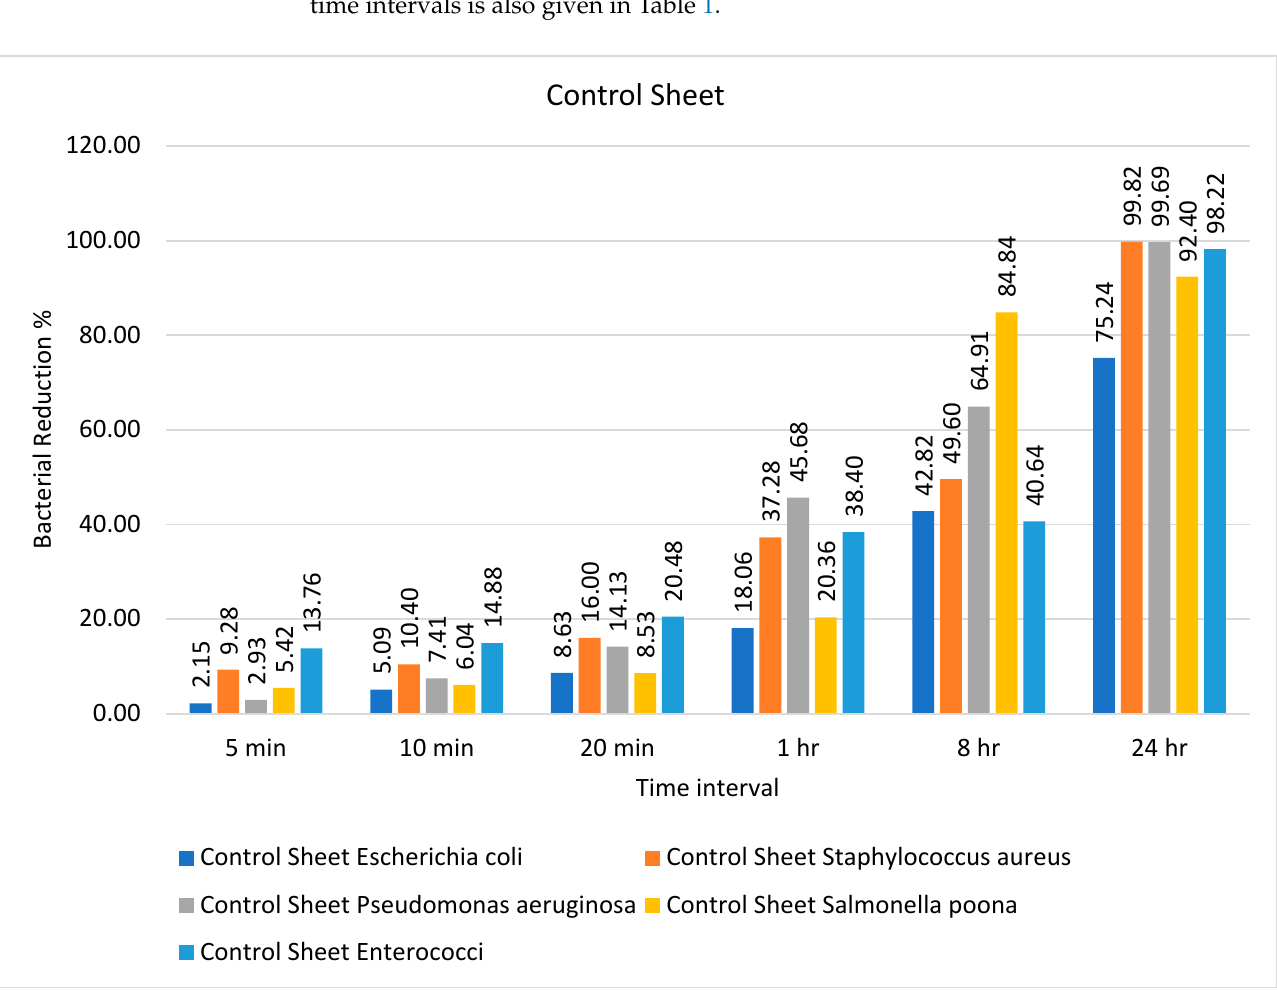
Figure 5. Percentage bacterial reduction for ‘control sheet’ over different time intervals. Table 1. Bacterial count on control sheet during different time